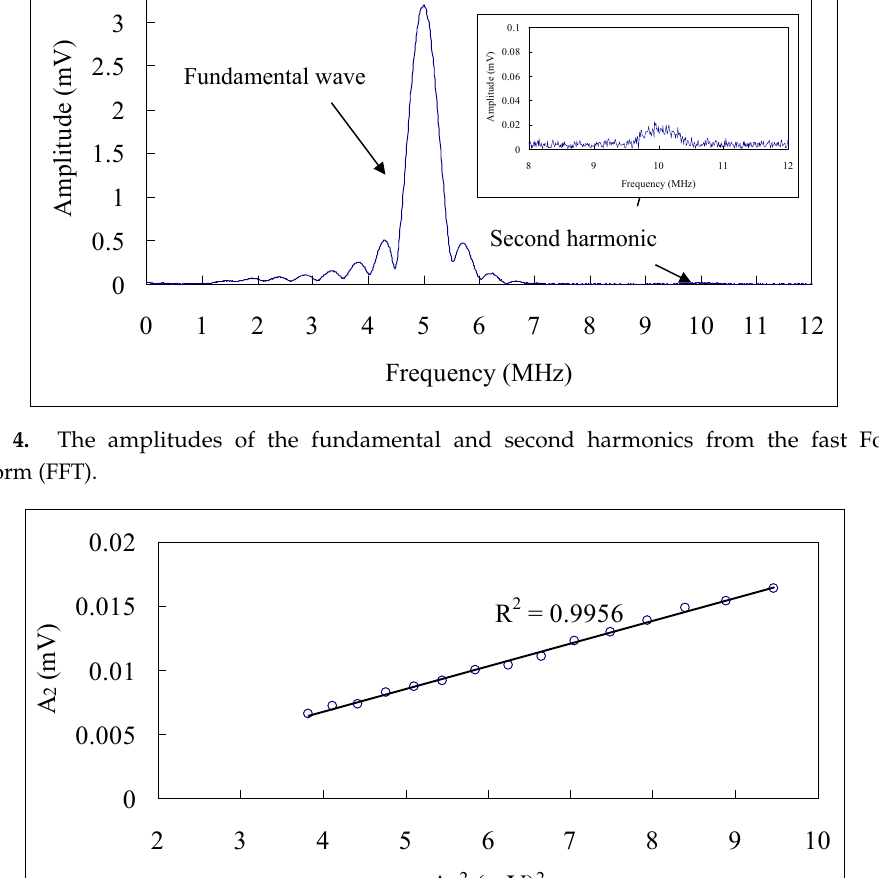
Figure 5. Second-harmonic amplitude A 2 versus the square of the fundamental wave amplitude A 1 with an increase of input voltage.